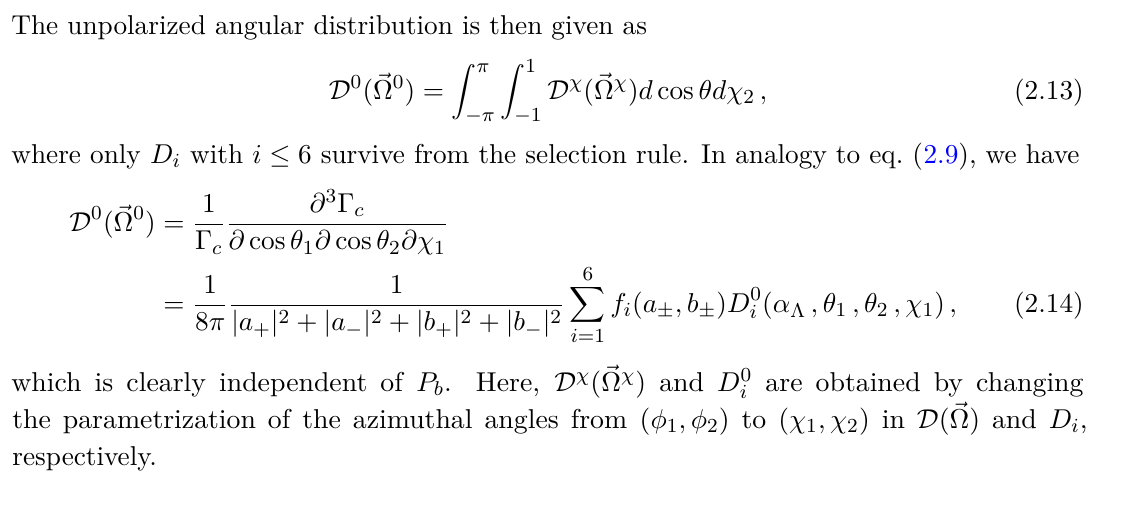
Table 1 . The parametrized angular distributions with the angles shown in figure 1, where P 2 is the Legendre polynomial with P